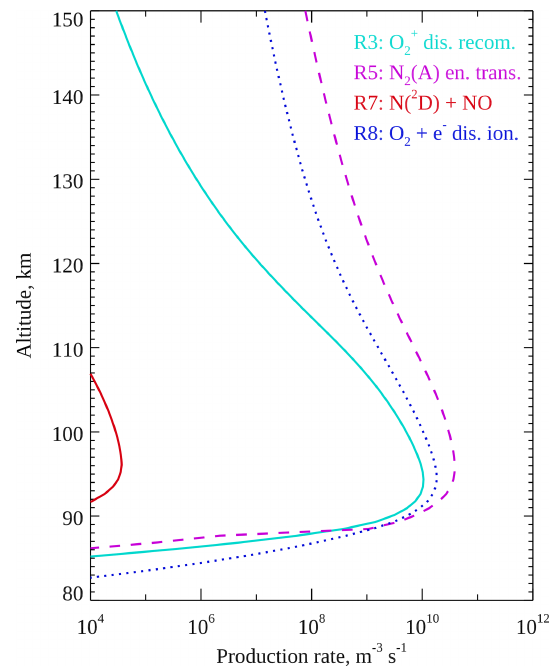
Figure 13. Modelled rate profiles after 12s of Gaussian electron precipitation at 25keV. The rates of Reactions (R3), (R5), (R7) and (R8) are plotted by solid cyan, dashed magenta, solid red, and dotted blue lines, respectively. Reactions (R3) and (R5) are production of O( 1 S ) and are exactly as plotted in Fig. 11. Reactions (R7) and (R8) are production of O in any